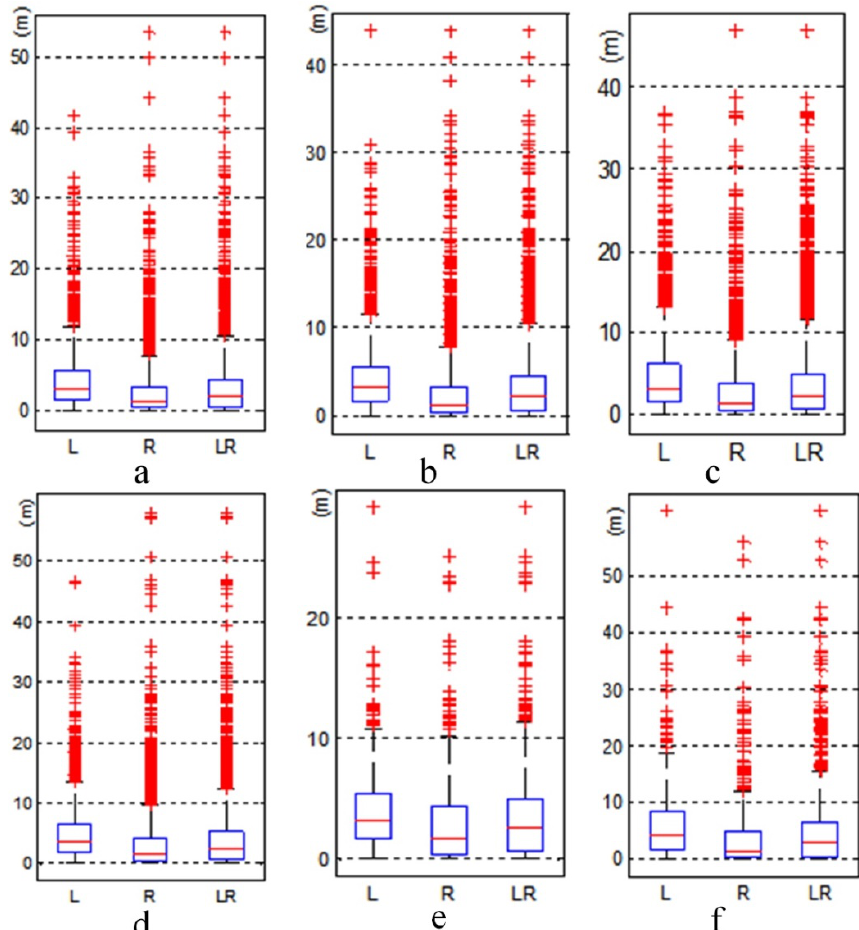
Figure 7. Boxplots of the LoD parameters based on the left bends, right bends, and all bends for six contour lines (the “ + ” symbol represents abnormal values). ( a ) Boxplot of the LoD parameters for the No.1 contour line. ( b ) Boxplot of the LoD parameters for the No.1 contour line. ( c ) Boxplot of the LoD parameters for the No.3 contour line. ( d ) Boxplot of the LoD parameters for the No.4 contour line. ( e ) Boxplot of the LoD parameters for the No.5 contour line. ( f ) Boxplot of the LoD parameters for the No.6 contour line.